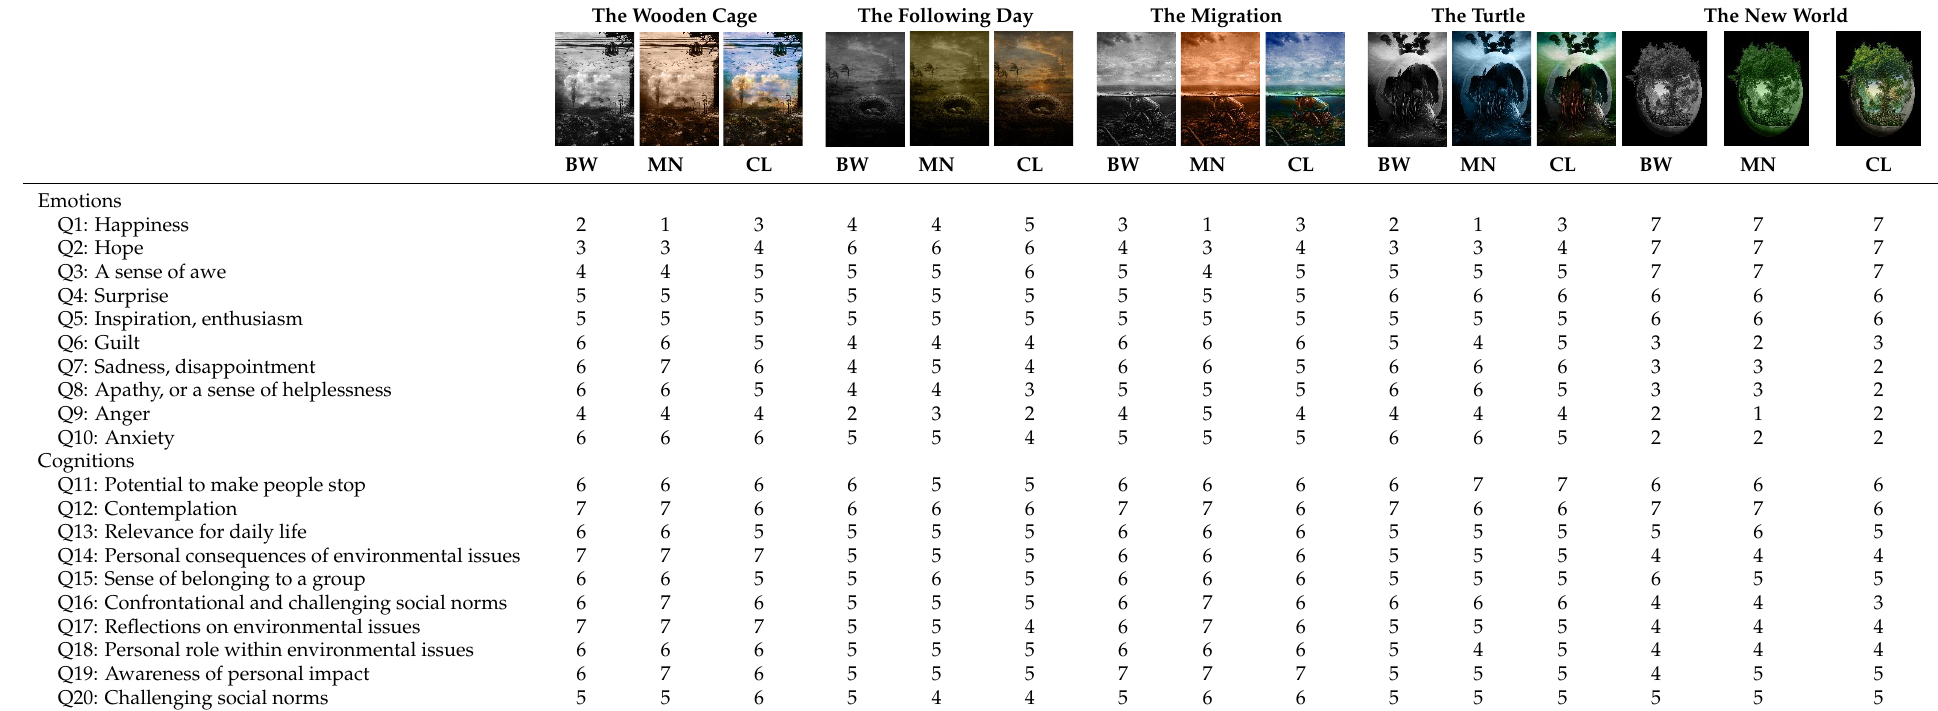
Table 1. The median results of emotions and cognitions of each image (BW = black-and-white, MN = monochrome, CL = color). The Wooden Cage The Following Day The Migration The Turtle The New World